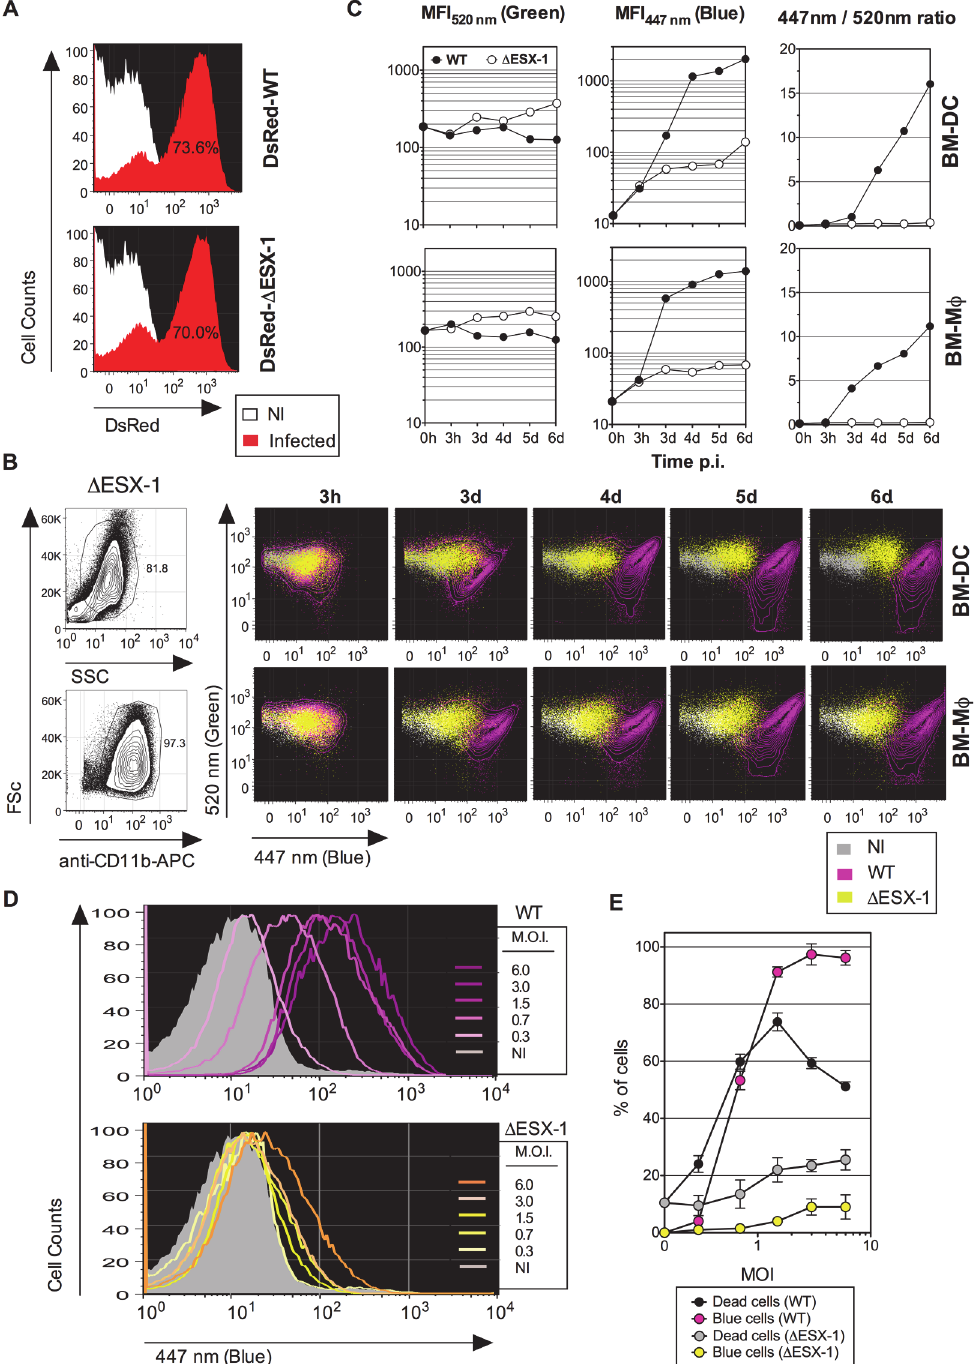
Fig 2. Mtb -mediated phagosome disruption in different phagocyte types, relationship with infection dose and cell death. (A) Comparative infectivity of WT and Δ ESX-1 Mtb . BM-DC were infected with DsRed-WT or- Δ ESX-1 strain and the red fluorescence was assessed by cytometry at 1 dpi. Percentages of cells having phagocytized DsRed-mycobacteria are indicated. (B) Detection of phagosomal rupture subsequent to infection with WT or Δ ESX-1 strains, as determined by green vs . blue CCF-4 signals in BM-DC or BM-M Φ , infected with untagged Mtb , WT or Δ ESX-1 (MOI = 1) at different time points, as detected after exclusion of cell debris and free bacteria by FSc/SSc gating and inclusion of CD11b + cells. (C) MFI 520 nm , MFI 447 nm and MFI 447 nm /MFI 520 nm ratios in infected BM-DC or BM-M Φ at different time points. (D) Phagosomal rupture, monitored at 4 dpi by CCF-4 staining, in BM-DC infected with different MOI of WT or Δ ESX-1 Mtb . (E) Percentages of dead cells, as determined by the use of Pacific Blue Dead/Live reagents, compared to those of cells displaying a CCF-4 blue shift. Due to the emission overlap of CCF-4-Coumarin and Pacific Blue fluorochromes, the two different assays were performed in separate tubes